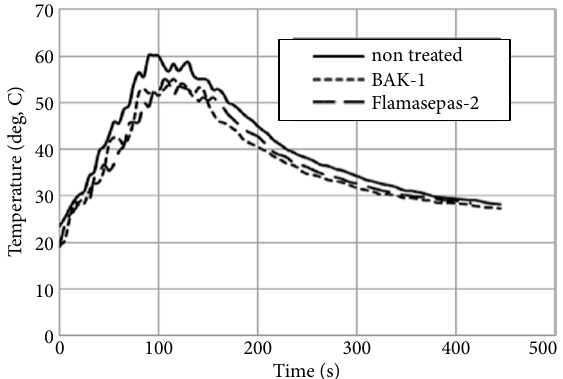
Fig. 19. Temperature during the combustion of non-treated and impregnated pine timbers measured by the thermocouple 18,3 located near the fire source at a height of 1.6 m